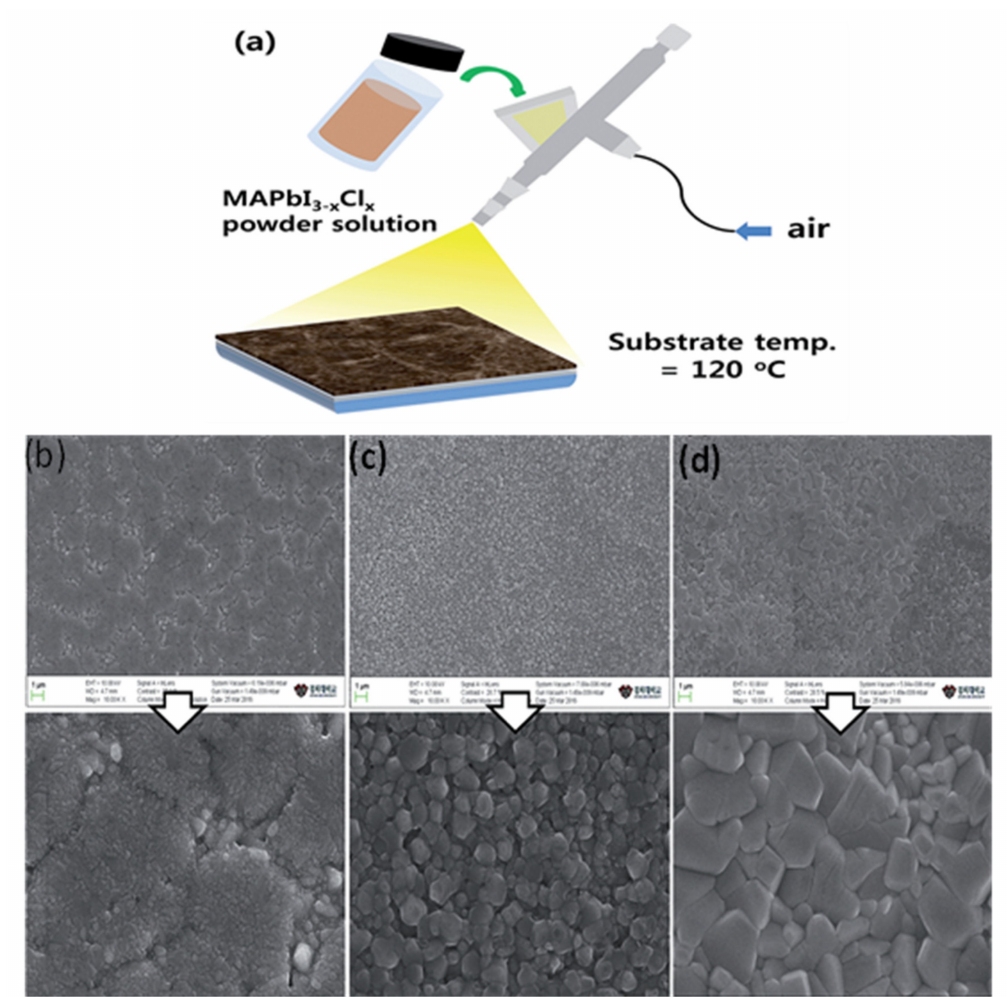
Figure 10. ( a ) Represents the fabrication of the MAPbI 3 − x Cl x mixed perovskite film by spray coating through a solution of MAPbI 3 − x Cl x mixed halide powder. ( b – d ) SEM images of MAPbI 3 − x Cl x mixed halide perovskite films at spraying times of 30 s ( b ), 60 s ( c ), and 90 s ( d ). Reproduced with permission from ref. [168], Copyright 2016, Journal of Materials Chemistry A